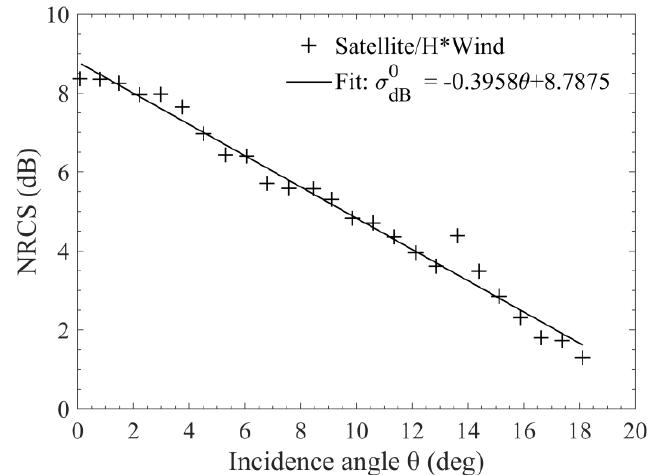
Figure 13. NRCS dependence on incidence angle at extremely high winds. Pluses are the NRCS values averaged over 37 m/s ≤ U 10 ≤ 45 m/s at different incidence angles. Overlaid is the linear regression fit.